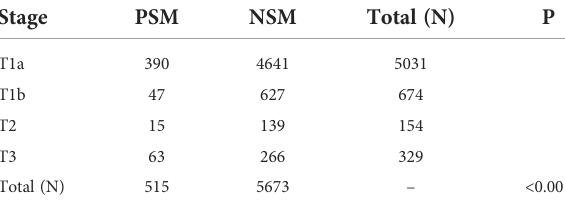
TABLE 2 Data of different tumor stages in 9 studies.